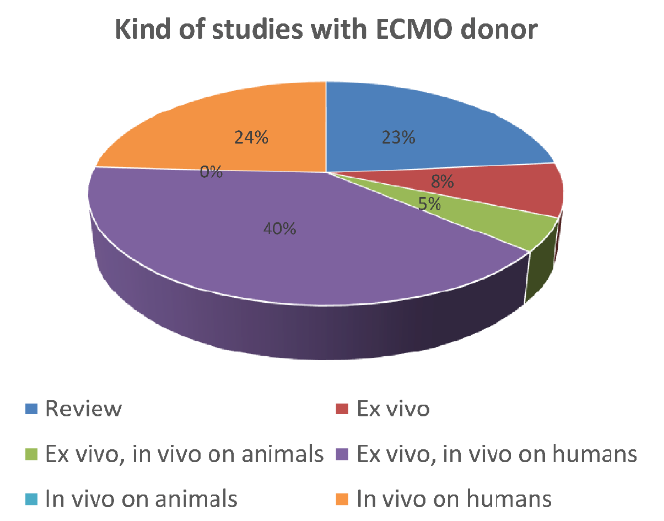
Figure 4. Type of study including ECMO donors.